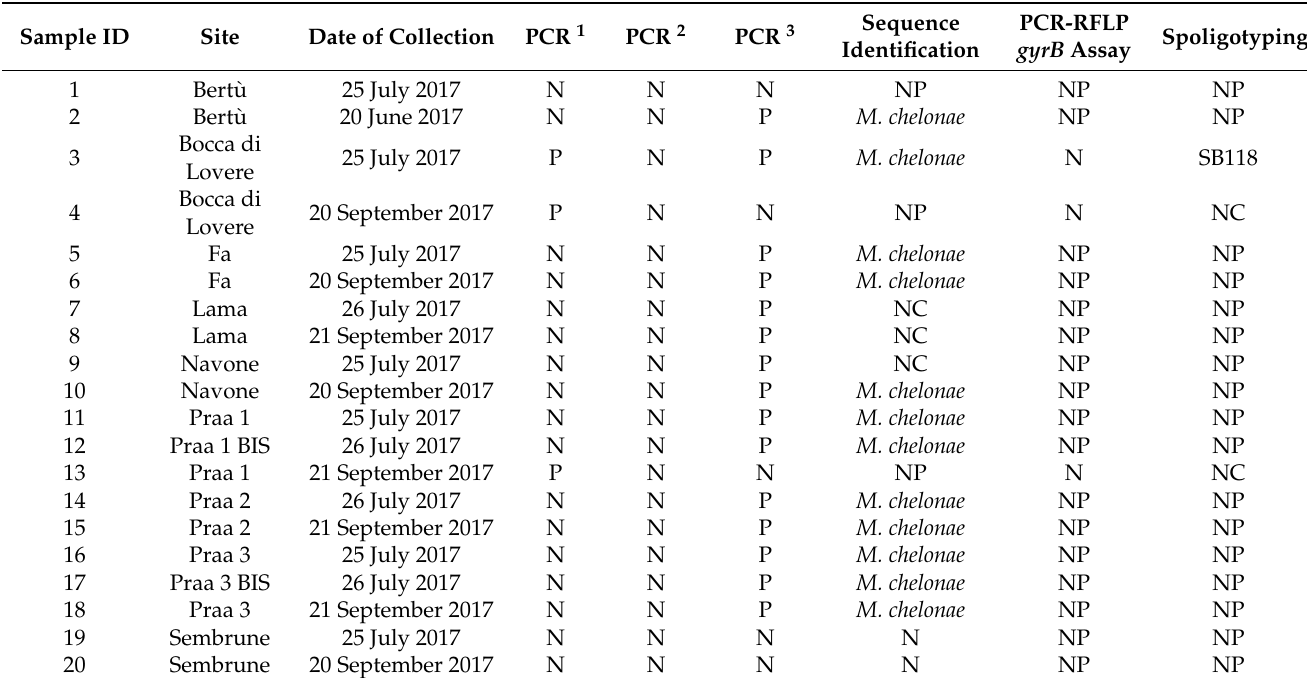
Analysis of water samples from the study sites (P = positive, N = negative, NP = not performed, NC = not